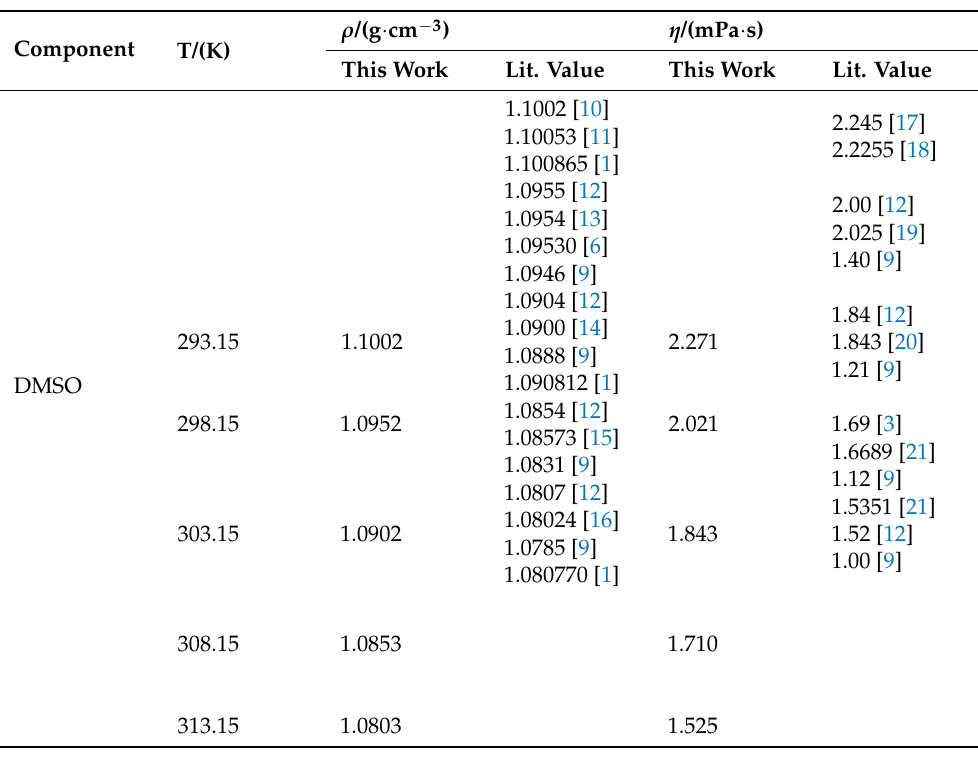
Table 2. Experimental and literature values of density ( ρ ) and viscosity ( η ) of the pure components in the temperature range from 293.15 to 313.15